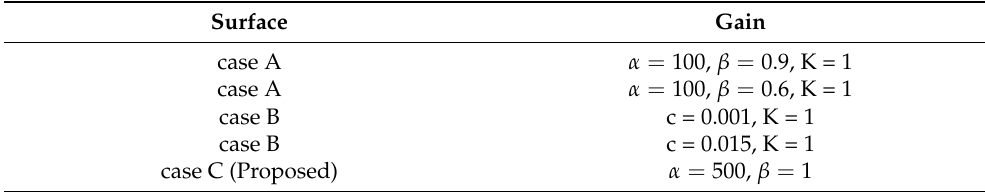
Table 2. Surface gains and constant values for the three